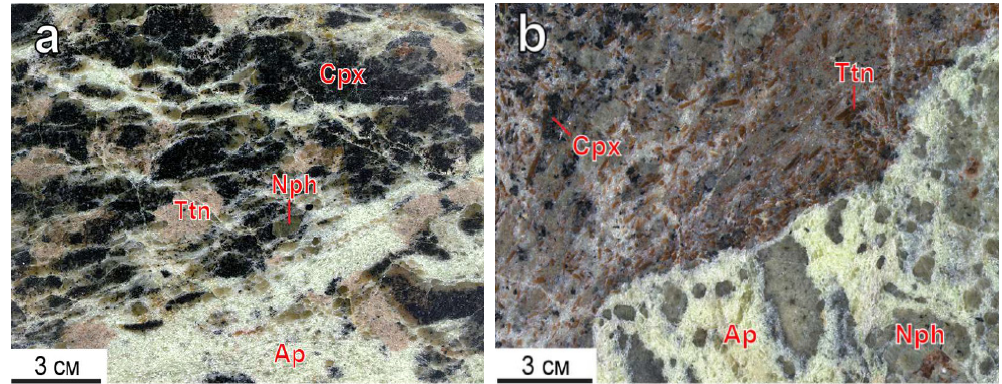
Figure 1. Titanite segregations in apatite-nepheline ( a ), apatite-titanite ( b ) ores of the Koashva apatite deposit, the Khibiny massif. Ap—fluorapatite, Cpx—clinopyroxene, Nph—nepheline, Ttn—titanite.